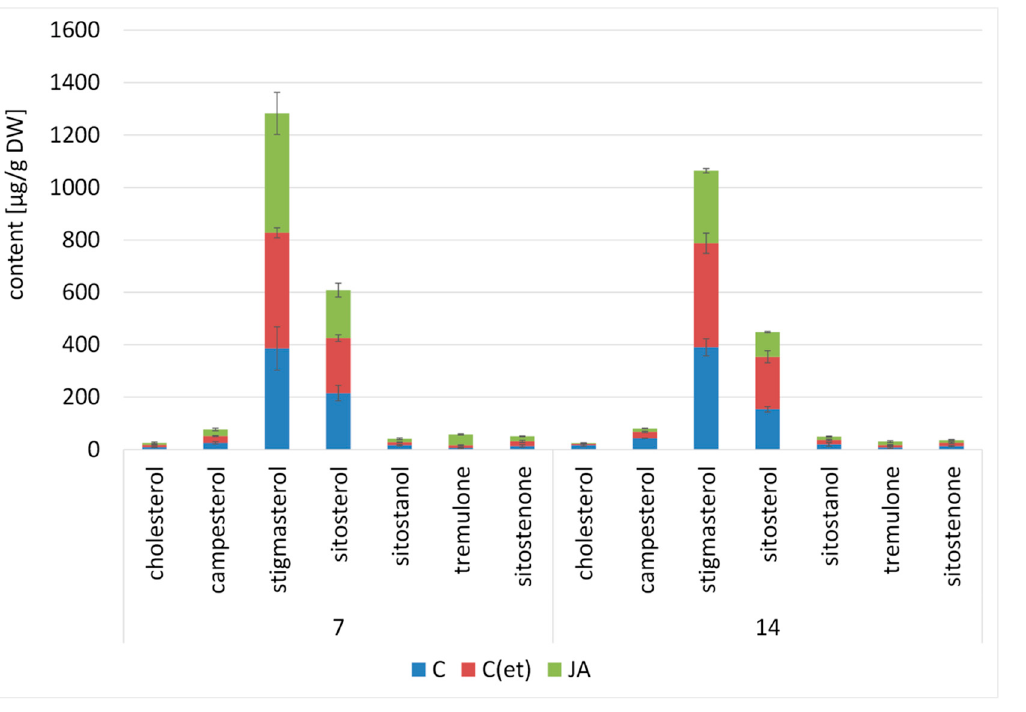
Figure 12. The content of free sterols in C. officinalis shoots. C—control, C(et)—control samples treated with the adequate volume of 70% ethanol, JA—jasmonic acid-elicited samples. Bars which do not share a common letter are significantly different. See detailed data and statistical significance in Table S21.